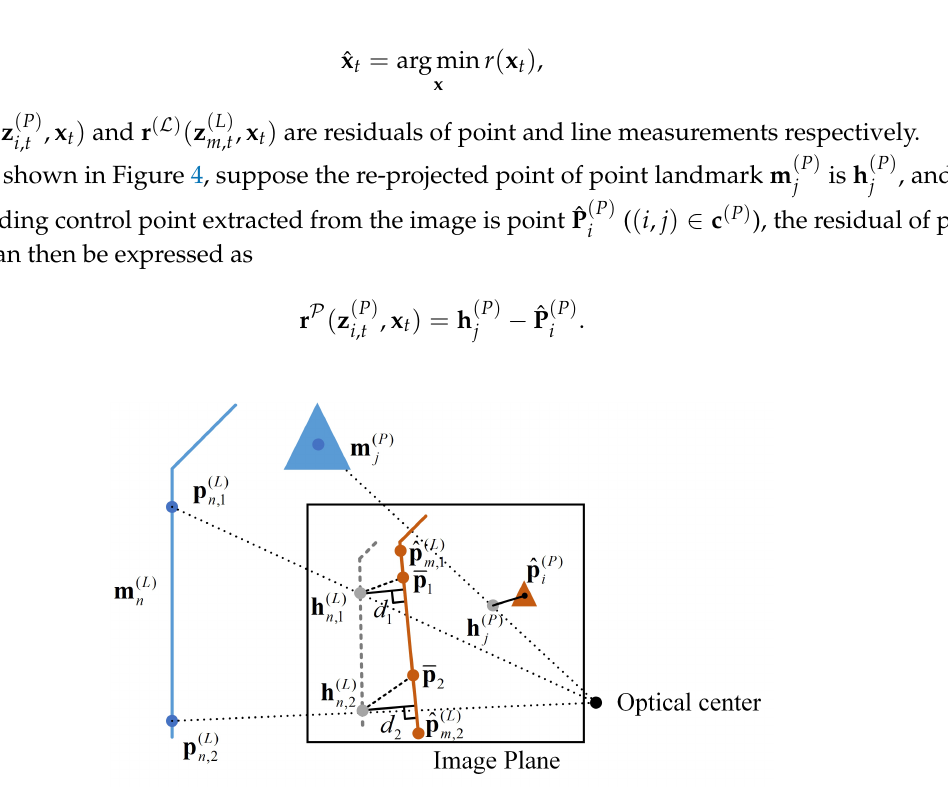
Figure 4. Definition of residuals. The landmarks in space denoted in blue; the recognized feature in gold; and the re-projection of map features in